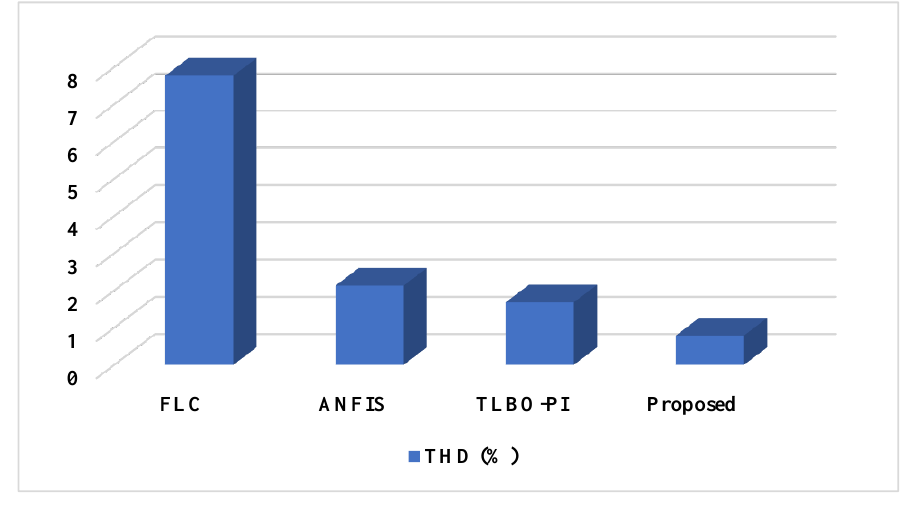
Figure 23. Comparison based on THD.